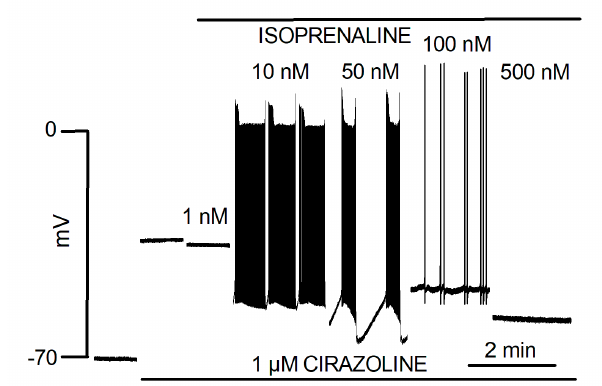
Figure 1. Automatic activity in cardiac muscle of the PV produced by the combination of α - and β -adrenergic receptor stimulation. Traces represent isolated segments of an otherwise continuous recording of membrane potential in cardiac muscle of one PV during the superfusion of 1 µ M Cirazoline and different concentrations of isoprenaline. Modified from Doisne et al. [33].